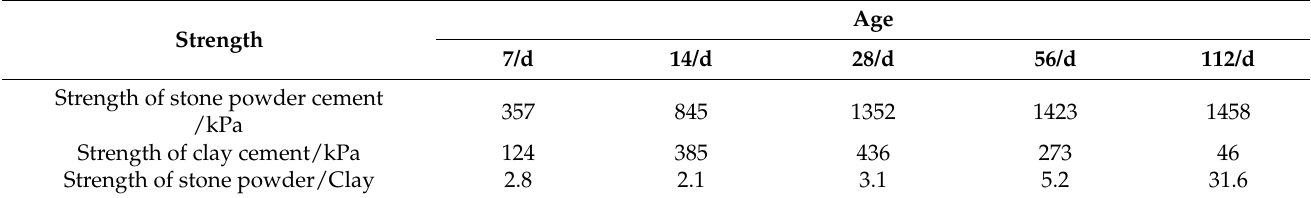
Table 8. Strength values and strength ratios of stone powder cement and clay cement hardened